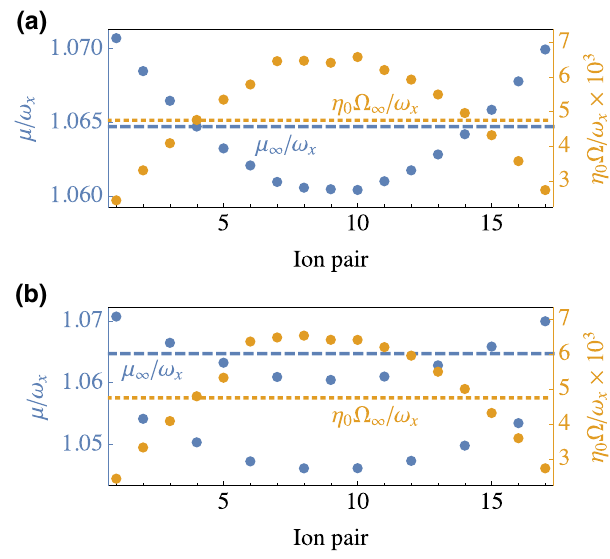
FIG. 6. Tweezer gates in finite chains. We show individual detunings and Rabi frequencies for 17 maximally entangling tweezer gates targeting the stretch mode along a chain of 130 ions with 15 buffer ions on each side ( p = 6, (cid:14) ≈ 0.07). Optical tweezers generate a trapping frequency that is uniform ν 0 = 0.4 and alternating between ν 01 = 0.4 and ν 02 = 0.36 for (a) and (b), respectively. For comparison, we also show the detuning μ ∞ and Rabi frequency (cid:4) ∞ for an infinite chain with (cid:14) = 0.07 and = 0.4. ν 0